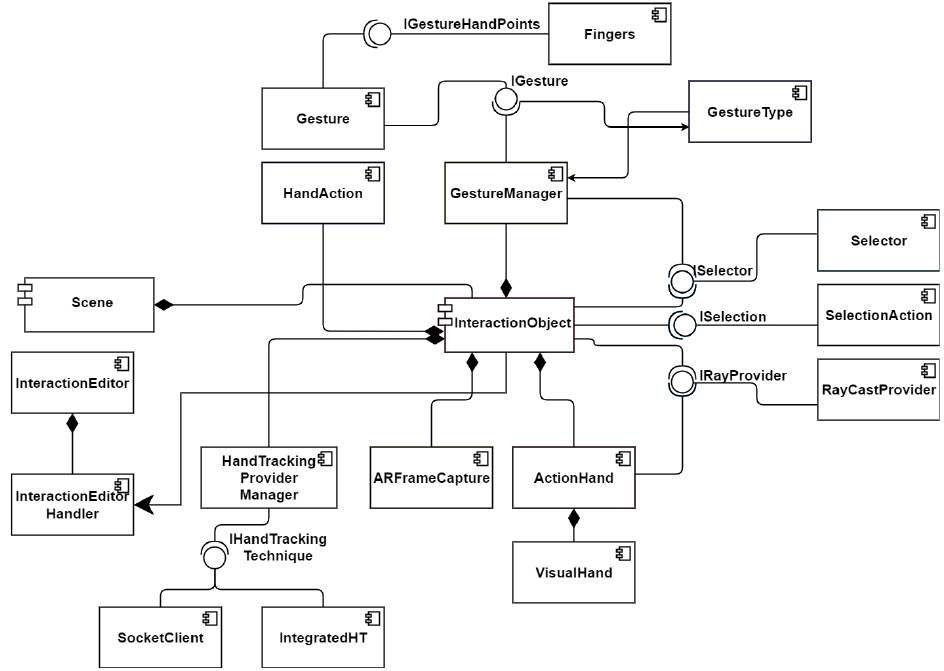
Figure 3. Hand Interaction Toolset Components.